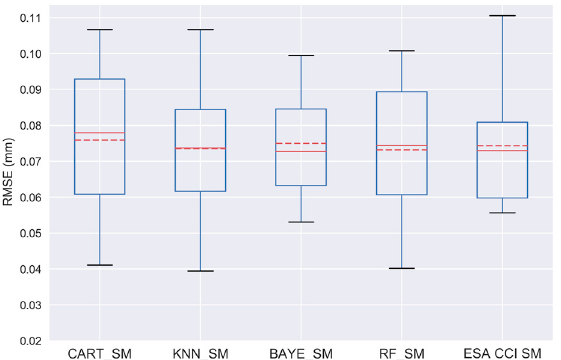
Figure 8. Box plot of RMSE (m 3 ·m − 3 ).